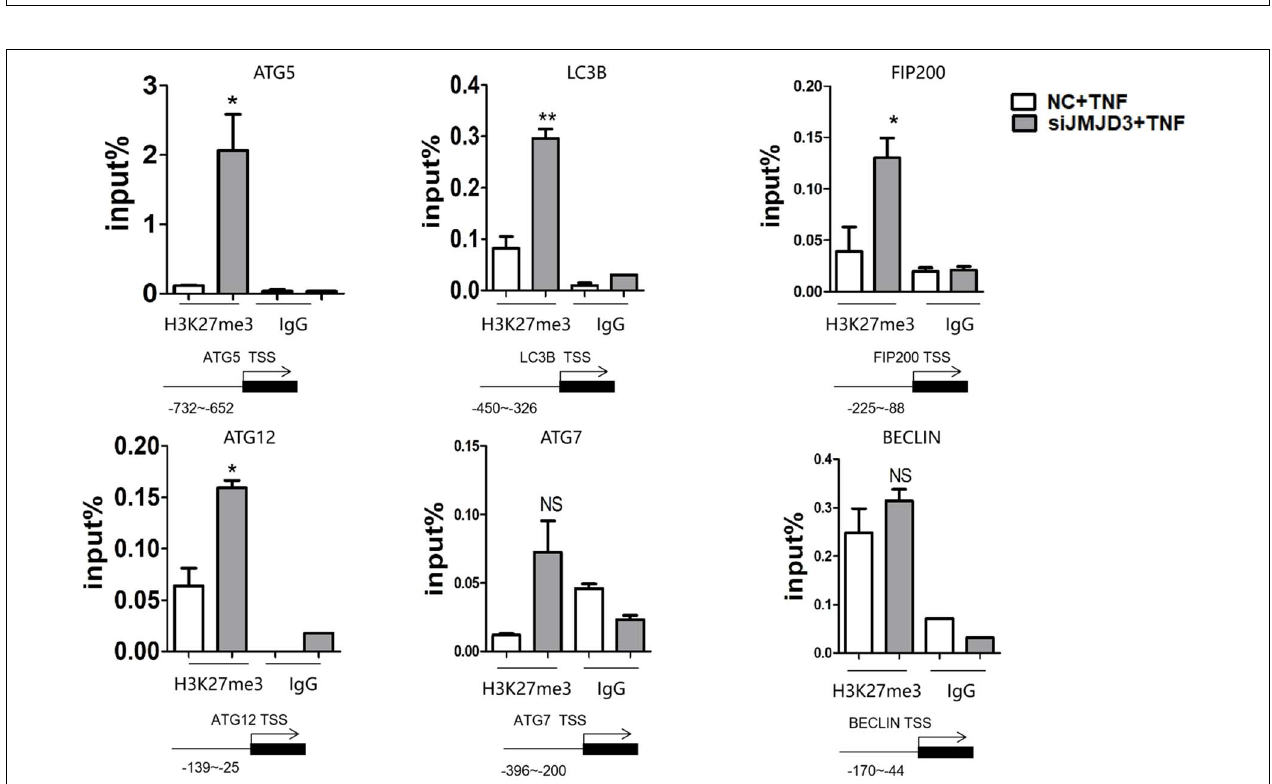
FIGURE 5 | JMJD3 regulated the expression of autophagy-related genes by regulating the H3K27me3 modification. JMJD3 siRNA up-regulated the H3K27me3 level binding to the promoters of ATG5, FIP200, ATG12 and LC3B. * P < 0.05, ** P < 0.01, ns non-significant.